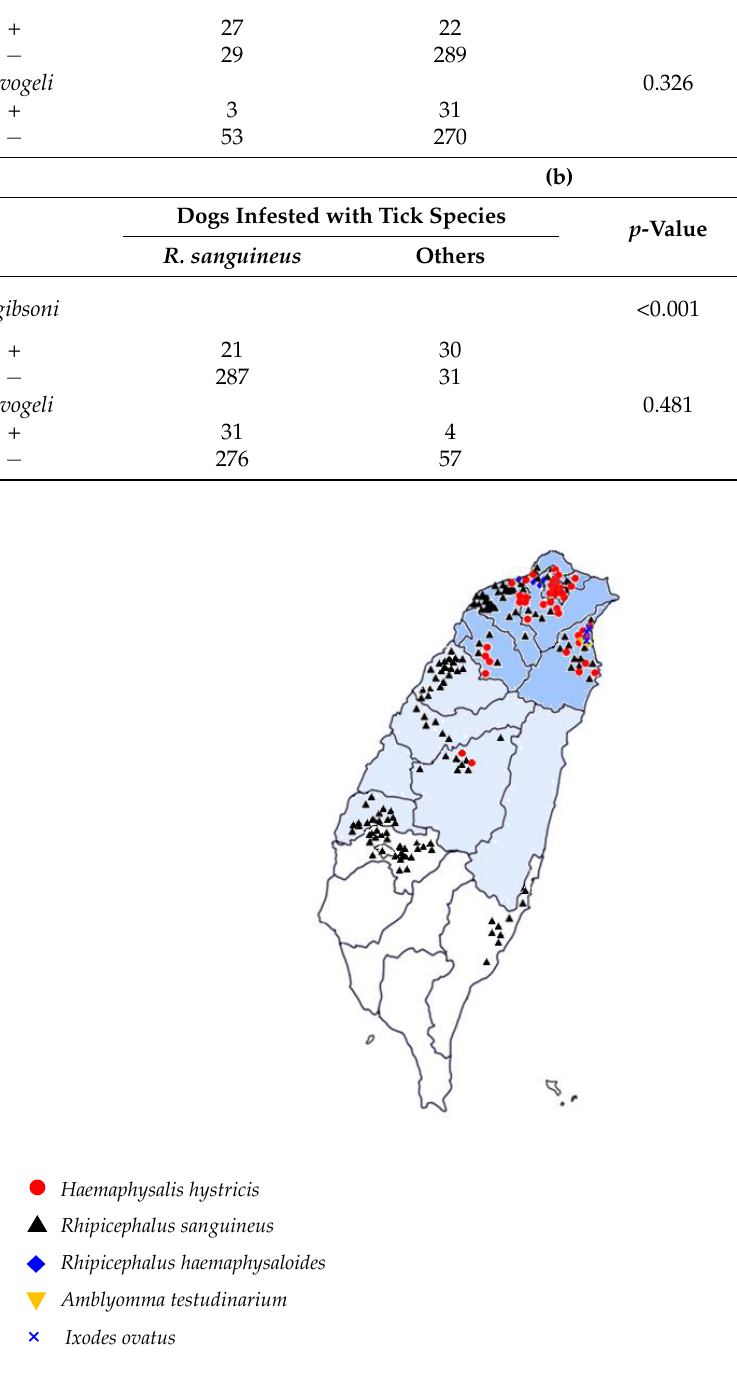
Figure 1. Distribution of tick species and the prevalence of Babesia spp. in the northern, middle and southern regions of Taiwan. Table 2. ( a ) The infection rate of Babesia spp. in dogs infested with H. hystricis and other tick species . ( b ) The infection rate of Babesia spp. in dogs infested with R. sanguineus and other tick species.